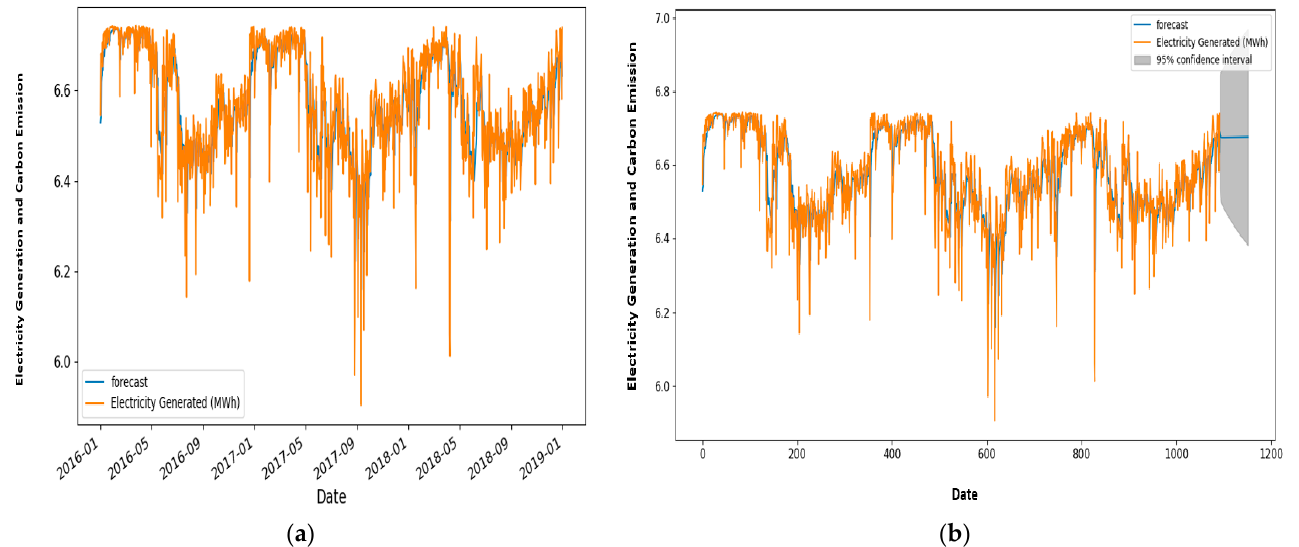
Figure 8. Test results: ( a ) autoregressive moving average RMSE values for ARIMA and ( b ) autoregressive moving average